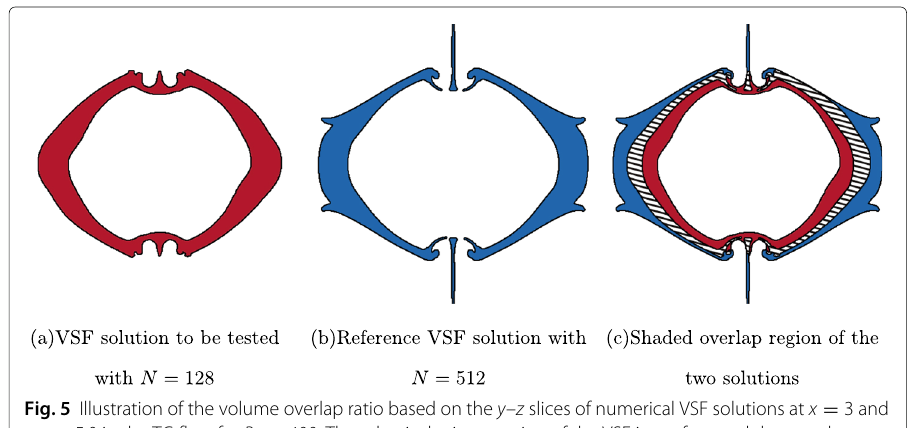
Fig. 5 Illustration of the volume overlap ratio based on the y – z slices of numerical VSF solutions at x = 3 and t TG = 5.0 in the TG flow for Re = 400. The edge is the intersection of the VSF isosurface and the y – z